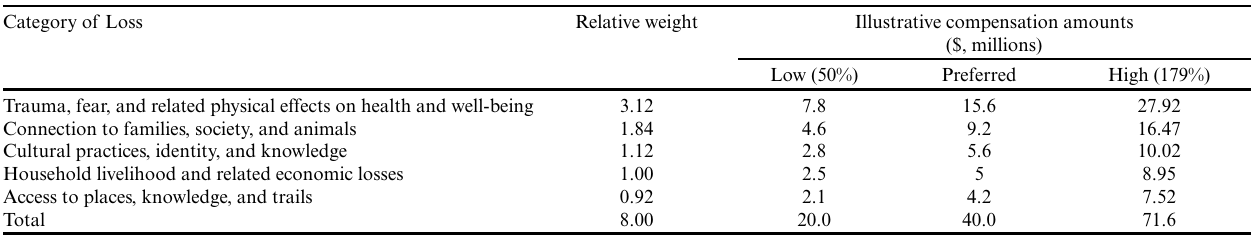
Table 3 . Relative weights and illustrative compensation amounts including uncertainty. All amounts in Canadian dollars. Category of Loss